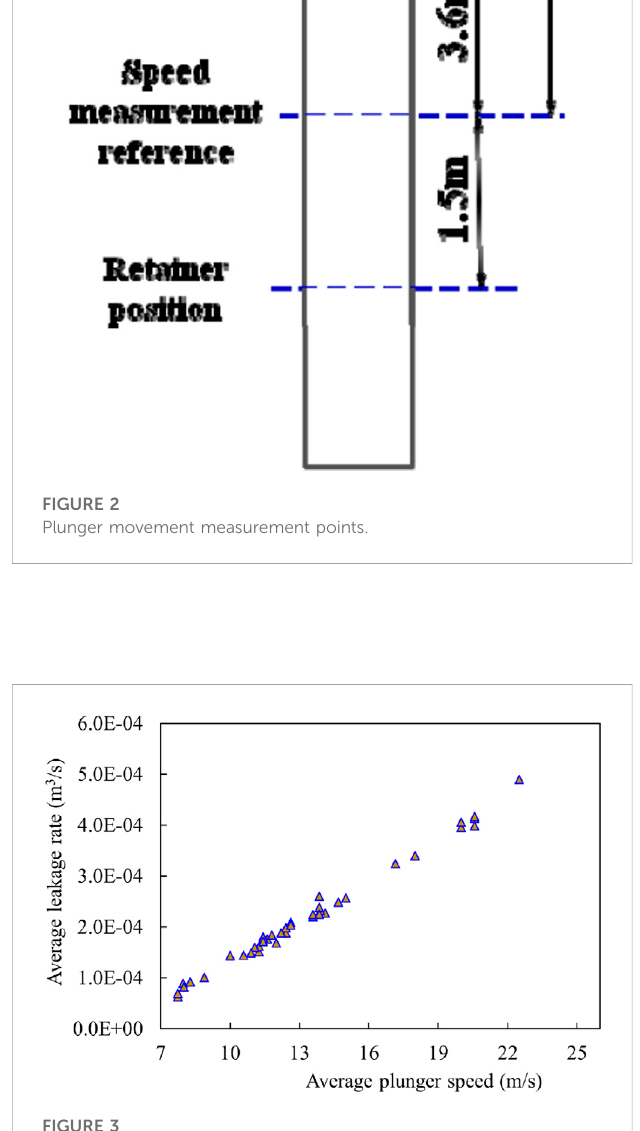
FIGURE 3 Change of average leakage rate with average plunger